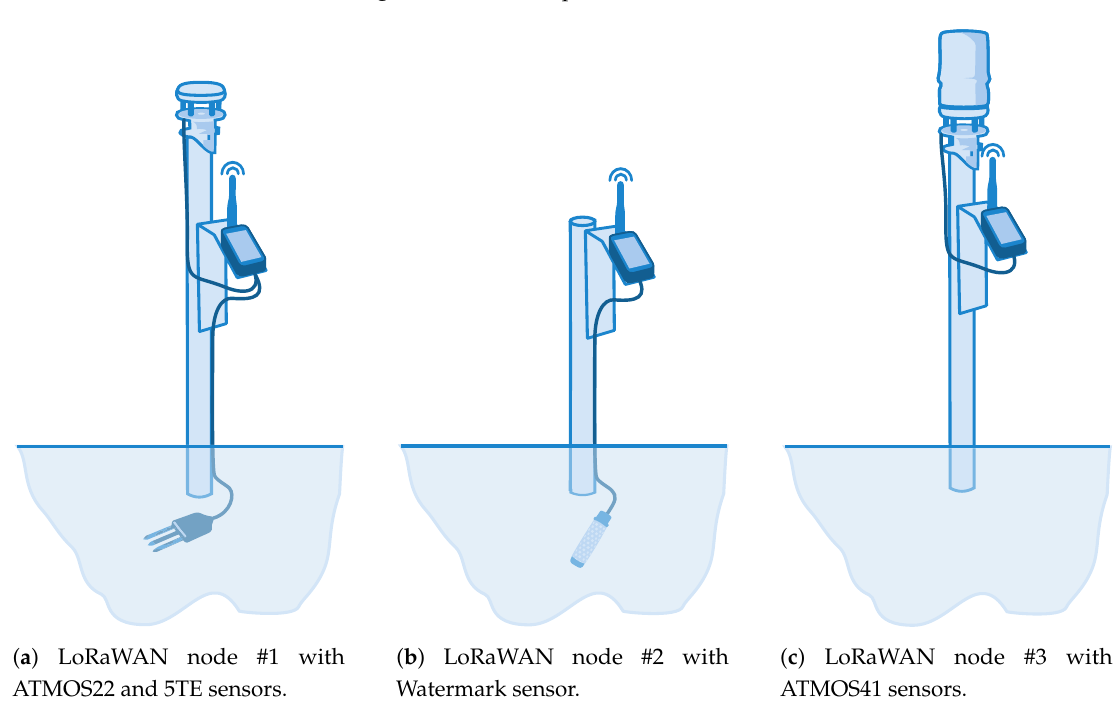
Figure 8. The developed LoRaWAN node.